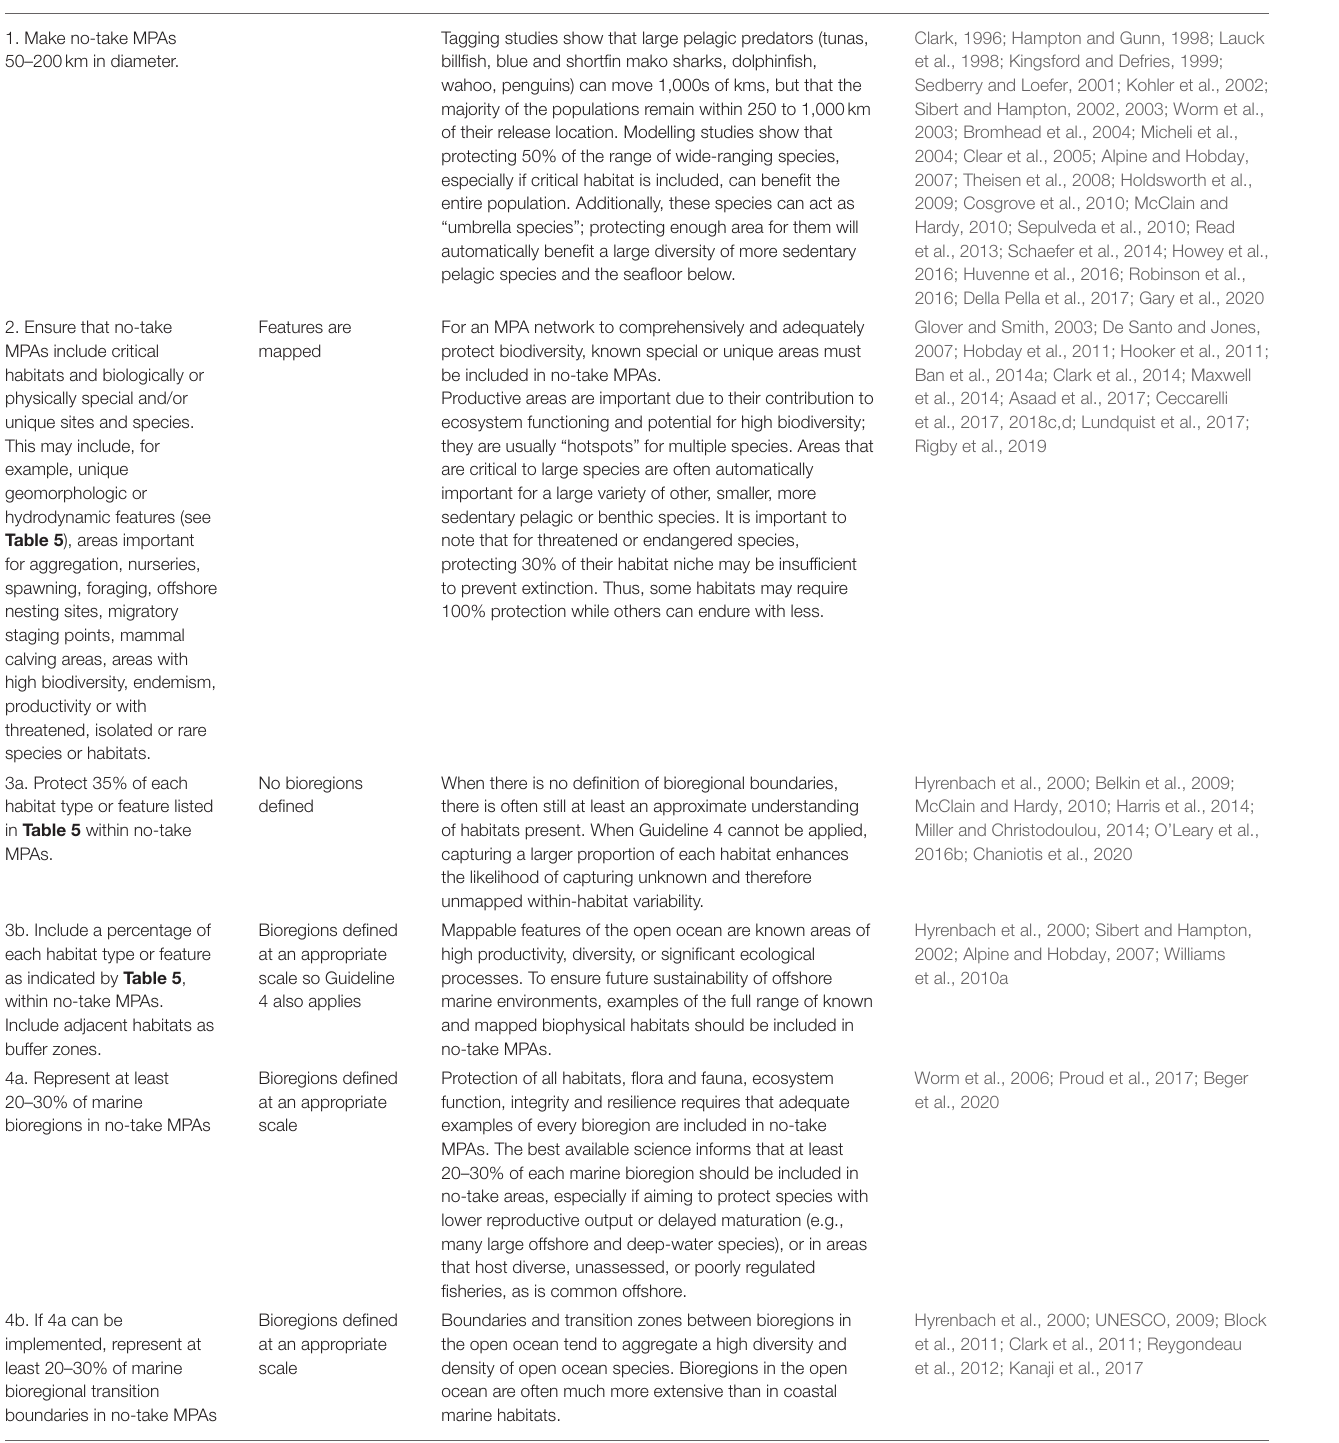
TABLE 2 | Summary of biophysical guidelines for the design of offshore networks of no-take MPAs. Design